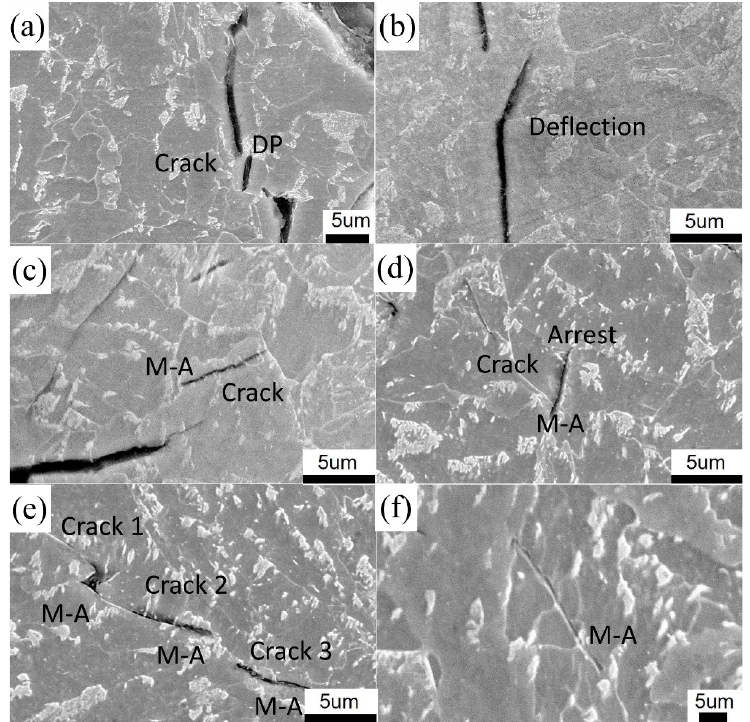
Figure 9. Misorientation angle distribution: ( a ) S1, ( b ) S2, and ( c ) S3. Table 4. The relative frequency of the HAGBs and LAGBs of an X80 × D1422 mm heavy-wall heat- induced seamless bend.